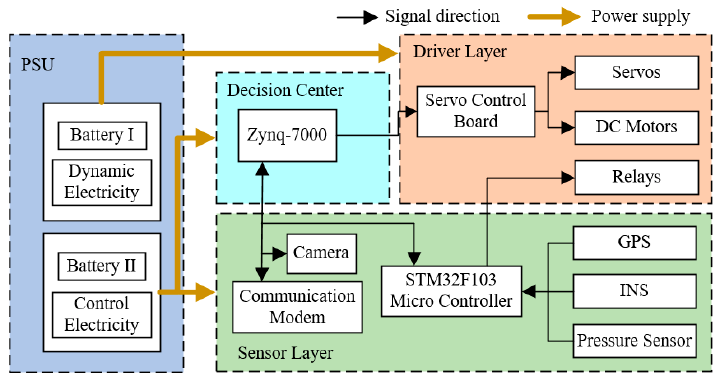
Figure 3. The circuit system of ASR-III. DC: direct current; GPS: Global Positioning System; INS: inertial navigation system.